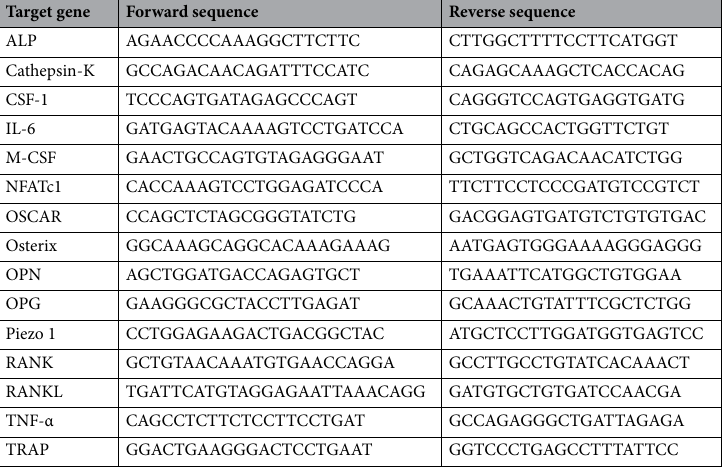
Table 1. Forward and reverse primer sequences for